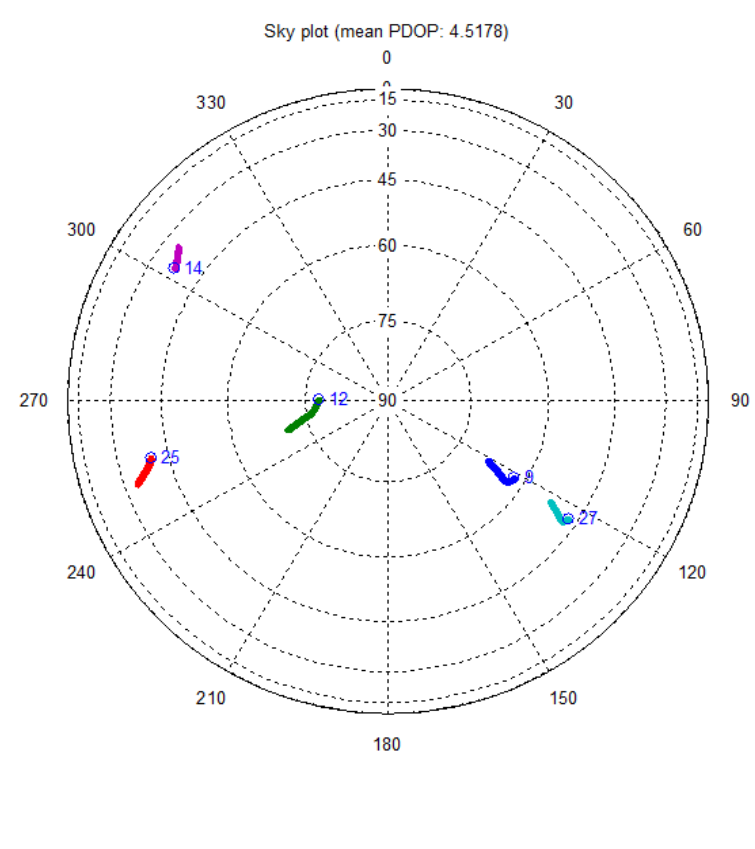
Figure 9. Estimated C/N